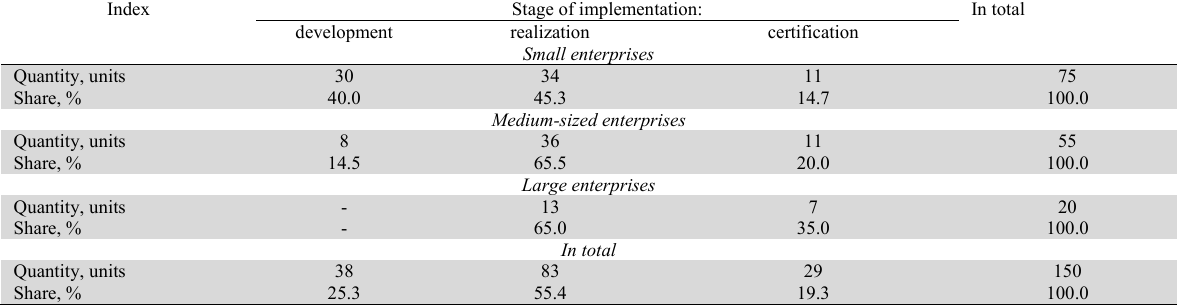
Distribution of agricultural enterprises in Ukraine by stages of implementation of environmental responsibility policy according to the size of enterprises,